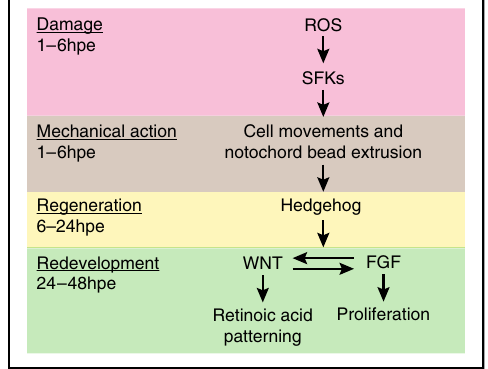
Fig. 8 A model for tail regeneration. This fi gure summarises our model for zebra fi sh larval tail regeneration. On the left side are the different stages of this process with the approximate timing. Please see the text for